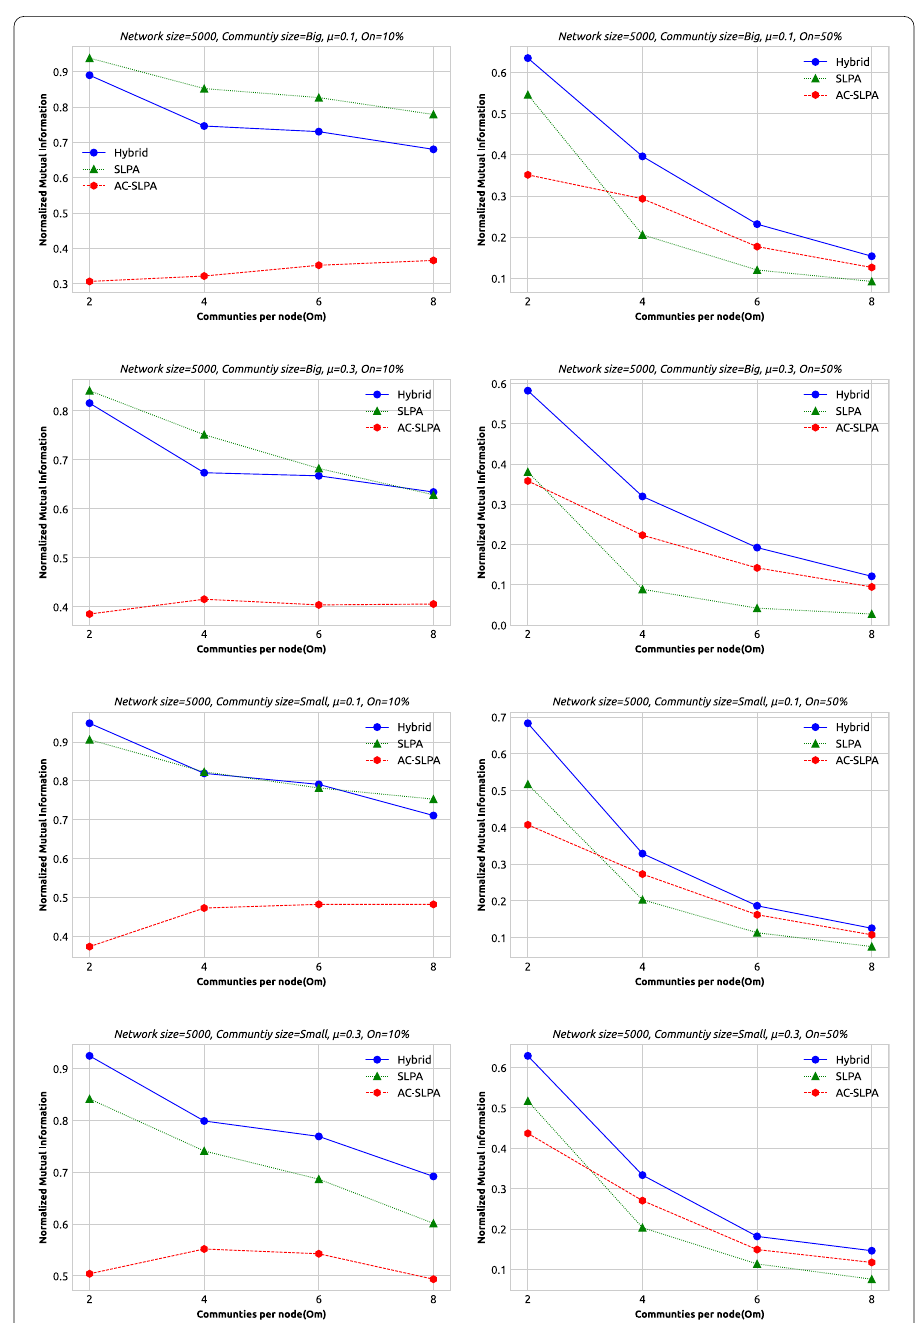
Fig. 11 Performance of AC-SLPA using Hybrid cleaning method compared to SLPA and AC-SLPA with noisy pairwise constraints on large synthetic networks , containing both small and large communities, where the mixing parameter µ varies from 0.1 to 0.3. NMI values are plotted against the number of communities per node ( O m